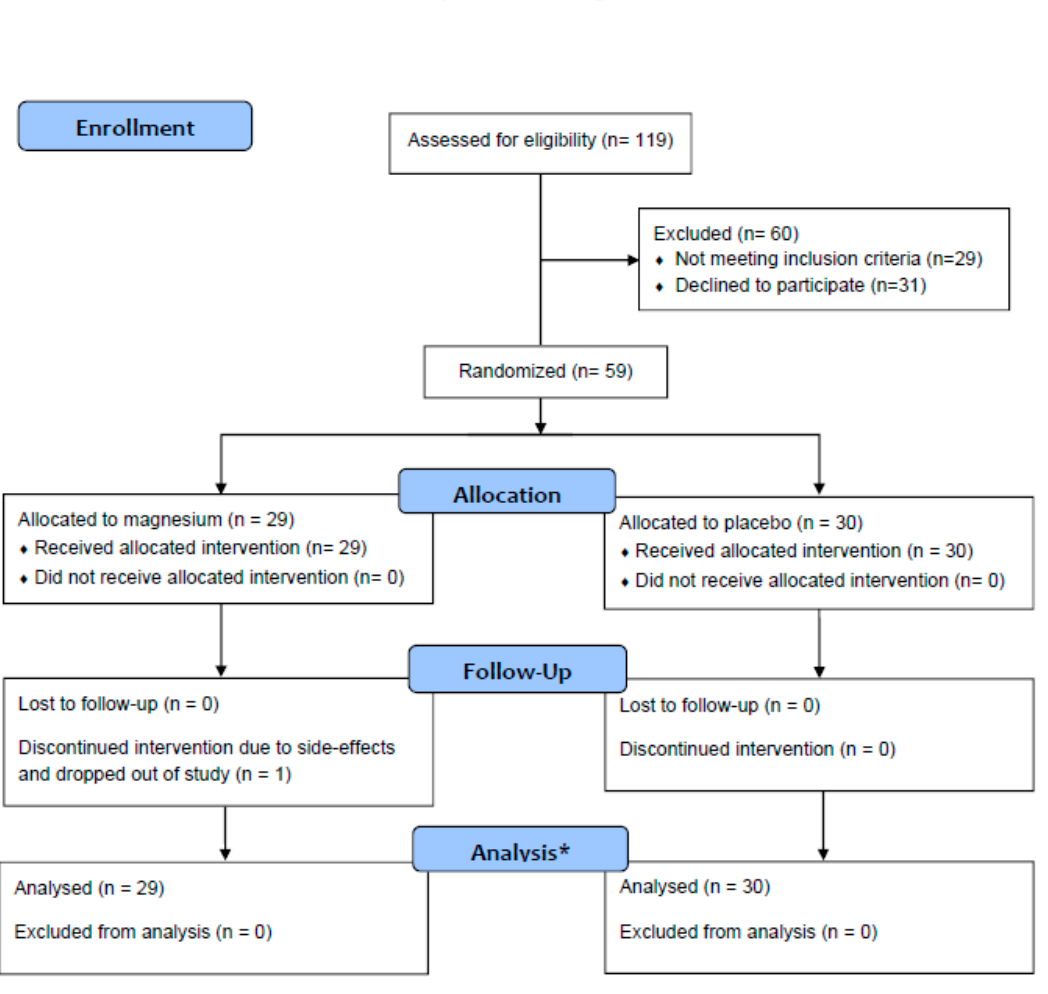
Figure 1. * Due to missing data on individual items, the total numbers of observations included in the linear models are 57, 57, 54, 54, 58, and 58 for the outcomes log premature atrial contraction (PAC) burden, PAC burden, serum magnesium, serum glucose, systolic blood pressure, and diastolic blood pressure, respectively.